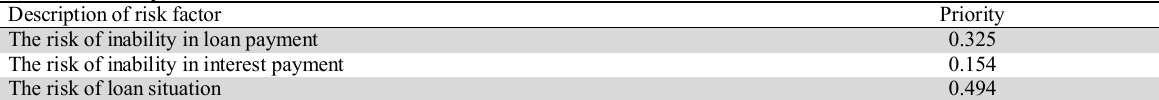
The summary of credit risk